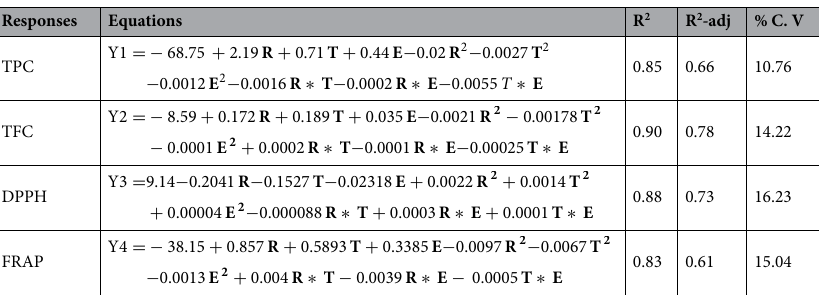
a regression equation was developed (Table 3). In addition, the high R 2 (0.85) and Adj-R 2 (0.66), the coefficient of variation CV (10.76) and the non-significant value for lack of fit (4.69) confirmed that the mathematical model of equation (Y1) was adequate to predict the total phenolic content according to the various combination of variables values. These results corroborate those of Iftikhar et al. 29 on rye bran matrices. Indeed, Fig. 1a shows that gentle heating contributes to the softening of plant tissues, especially the cell wall, and to the hydrolysis of the bonds between phenolic compounds and cellular components (phenol–protein or phenol-poly-saccharide). As a result, the extracted phenolic yield would be higher 30 . The diffusion process takes place due to the concen- tration gradient, according to Fick’s law. Thus, a high concentration contributes to a saturation of the reaction medium and a low diffusion of the extraction solvent 31 . Figure 1b, c show that a long extraction time contributes to an improved phenolic profile. Due to the extensive contact between the solvent and the solid material, the extractability of phenolic compounds is improved by diffusion or destruction of the cell wall 32 . However, high temperature for a long time could reduce the phenolic content due to polymerisation reactions between the compounds 33 . Analysis of variance (ANOVA, p < 0.05) for total flavonoid content showed that the model and quadratic coefficients (A, B, and C) were significant, in contrast to their interaction (Table 4). In addition, they had a significant correlation coefficient (R 2 = 0.90) and adequate experimental data for the estimated model (no fit, p > 0.05) (Tables 3,4), suggesting an approximation of a real system 34 . Total flavonoid content is optimized by elevated temperature, long extraction time and unsaturated solvent–solute concentration (Fig. 1d–f ) . However, the extraction of flavonoids is optimal for a combination of ultrasonic effects with cavitation, low to medium temperatures (between 20 and 70 °C), due to the electro sensitivity of these bioactive molecules 35 . Influence of operational parameters on antioxidant activities. Two estimation methods (DPPH and FRAP) were used for the assessment of antioxidant activity 36, 37 . The quadratic model used was associated